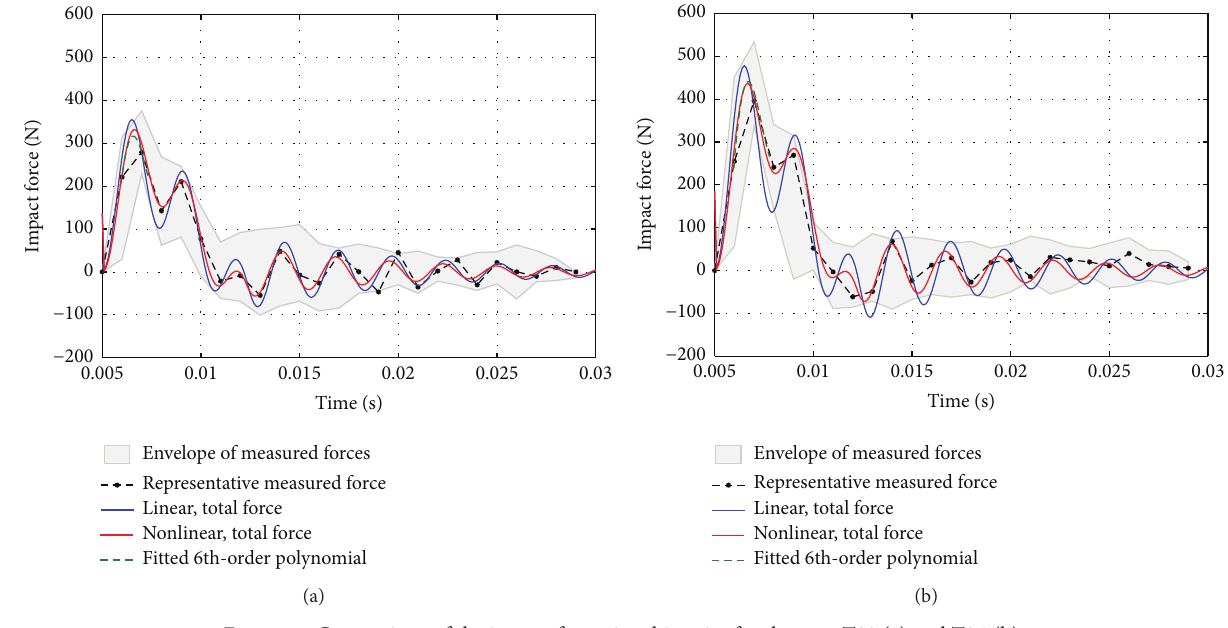
Figure 5: Comparison of the impact force time histories for the tests T02 (a) and T04 (b).